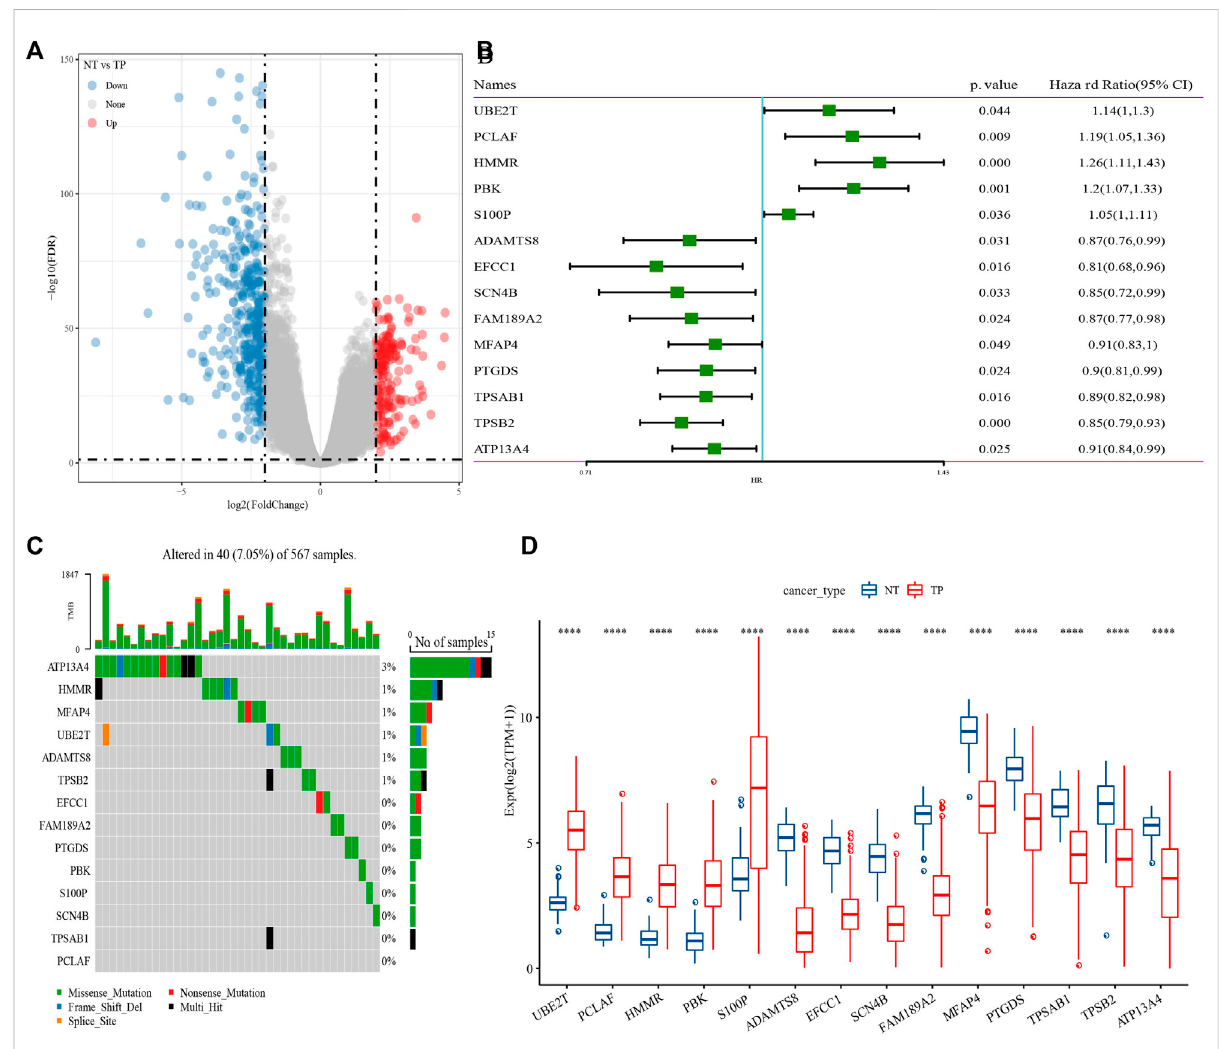
FIGURE 1 Identi fi cation of genes closely related to cuproptosis related gene pathway score. (A) Differentially expressed gene between cancer tissue and para-carcinoma tissue. (B) 14 genes closely related to cuproptosis related gene pathway score. (C) mutation analysis of genes in TCGA-LUAD dataset. (D) The expression levels of 14 genes in cancer tissue and para-carcinoma tissue. *** p <